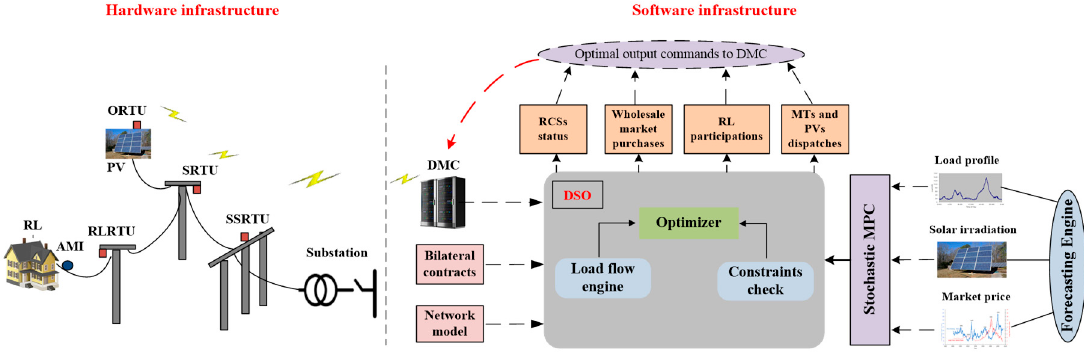
Figure 1. Conceptual design of the proposed Distribution Management System (DMS).